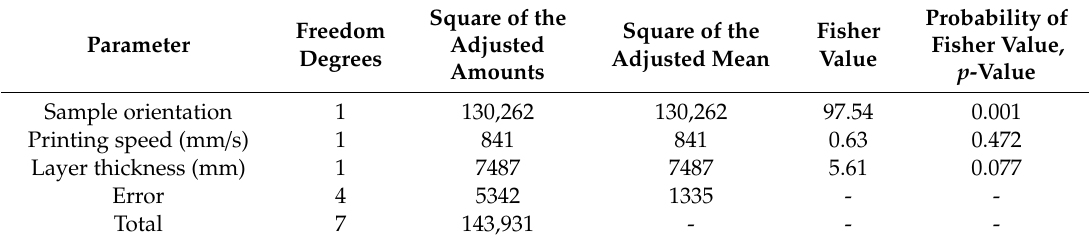
Table 3. The variance analysis results by the ANOVA method for the modulus of elasticity (Extrudr BDP Flax samples).